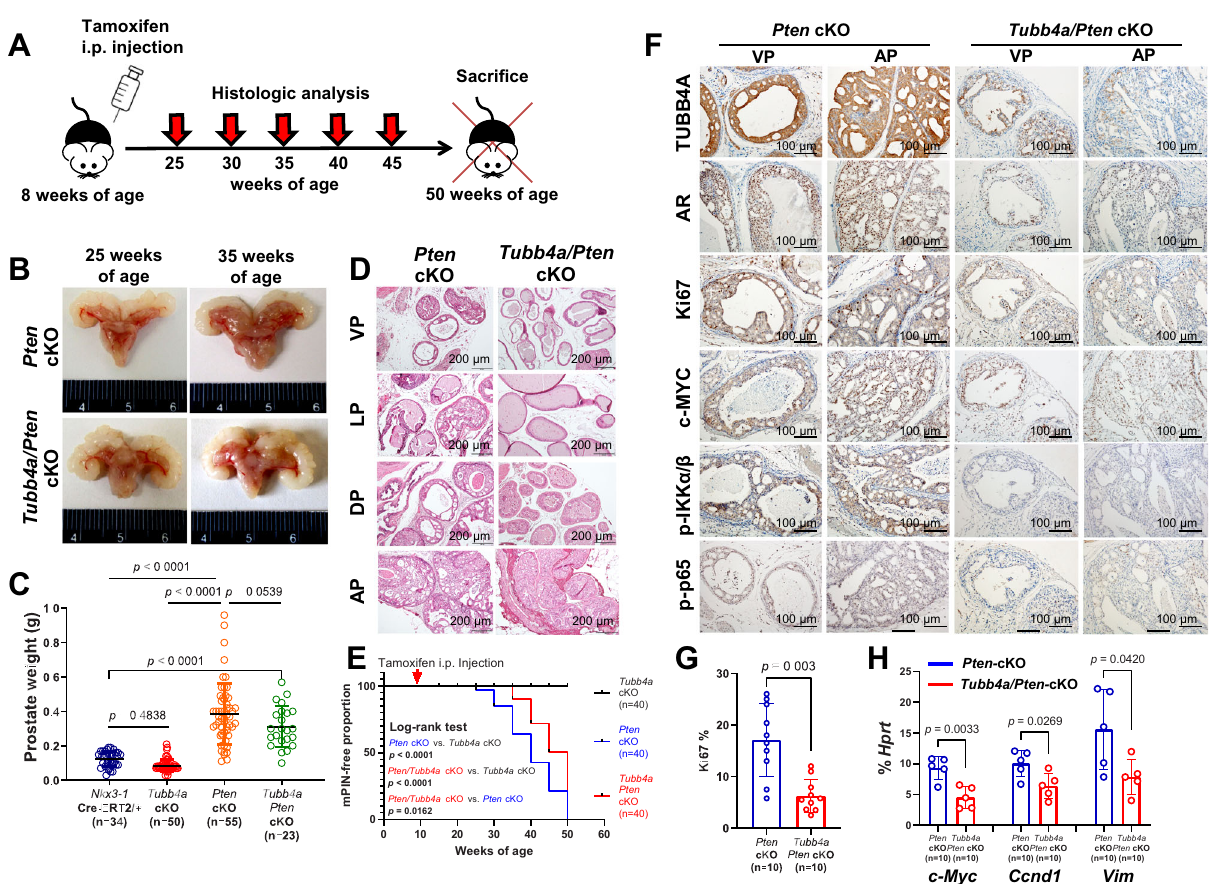
Fig. 8 Prostate-speci fi c deletions of Tubb4a and Pten and tumor progression in mouse prostate. A Schematic diagram of spontaneous developed prostate tumors followed for up to 50 weeks of age in genetically engineered mouse models. B Representative mouse prostates at 25 and 35 weeks of age. C Weights of prostates in the mice at 35 weeks of age. D Representative H/E staining of mouse prostates at 35 weeks of age. Scale bar, 200 µ m. E Kaplan – Meier curves of mPIN incidences for up to 50 weeks of age. At 20, 25, 30, 35, 40, 45, and 50 weeks of age, 5 mice/per time point were sacri fi ced for pathologic analysis. F Representative immunostaining for TUBB4A, AR, Ki67, c-MYC, p-IKK, and p-p65 in the prostates of mice at 35 weeks of age. Scale bar, 100 µ m. G The percentage of Ki67 cells as an indicator of proliferating cells among the mouse prostate or tumor tissues. H Relative mRNA levels of c- Myc , Ccnd1 , and Vim genes as a percentage of Hprt expression in microdissected prostate epithelial cells as determined by qPCR at 35 weeks of age. Data are replicated 5 ( H ), 10 ( G ), 23 – 55 ( C ), and 40 ( E ) times. Data are presented as the means and SD with a two-tailed t test ( G , H ) or an ANOVA followed by Tukey ’ s post hoc t test ( C ). Source data are provided as a Source data fi le. AP, anterior prostate; DP, dorsal prostate; LP, lateral prostate; VP, ventral prostate; cKO, prostate conditional knockout; mPIN, mouse prostatic intraepithelial neoplasia; AR, androgen receptor; i.p., intraperitoneal delayed in homozygous Tubb4a- cKO (also Tubb4a -cKO) statistically signi fi cant ( p = 0.079, Fig. S11D). In addition, mPIN TRAMP mice compared to heterozygous Tubb4a- cKO or Tubb4a lesions in all mice were AR-positive, but AR expression was wild-type (WT) TRAMP mice. Likewise, at 30 weeks of age, reduced after Tubb4a cKO (Fig. 8F). However, less expressions of prostate weights were decreased in homozygous Tubb4a- cKO Ki67 + , c-MYC, p-IKK α / β , and p-p65 were present in Tubb4a/ Pten- cKO versus Pten- cKO mPIN lesions (Fig. 8F, G). Since mice versus heterozygous Tubb4a- cKO or Tubb4a WT TRAMP expressions of c-MYC, cyclin D1, and vimentin were reduced mice (Fig. 9F). The TRAMP mice developed lymphatic and lung after TUBB4A KO (Figs. 5E and S7D), we analyzed the mRNA metastases starting at 25 weeks of age 35 . As summarized in Fig. 9G, most cancers in Tubb4a WT or heterozygous Tubb4a- expression of β -catenin - targeted genes c- Myc , Ccnd1 , and Vim in cKO TRAMP mice had progressed to poorly differentiated microdissected tumor cells. As shown in Fig. 8H, expression levels carcinomas (14~15/20) and lymphatic (8/20) and lung (5/20) of c- Myc , Ccnd1 , and Vim were lower in Tubb4a/Pten- cKO versus metastases at 30 weeks of age. In contrast, the homozygous Pten- cKO tumor cells, supporting indirect transcription regula- Tubb4a- cKO TRAMP mice developed poorly differentiated tion of these β -catenin targeted genes by TUBB4A. carcinomas (7/20), and few mice had lymphatic (3/20) and lung (1/20) metastases. At 35 weeks, IHC analysis showed AR + prostate tumors in all mice, but expressions of Ki67 + , c-MYC, p-IKK α / β , and p-p65 were lower in Tubb4a -cKO TRAMP versus WT TRAMP prostate tumors (Fig. 9H, I). Of note, at 12 weeks of age, low expressions of c-MYC, p-IKK α / β , and p-p65 were evident in the pre-malignant stage of tumor initiation (Fig. S12A). CK5 is a prostate basal cell marker, and its absence of basal cells